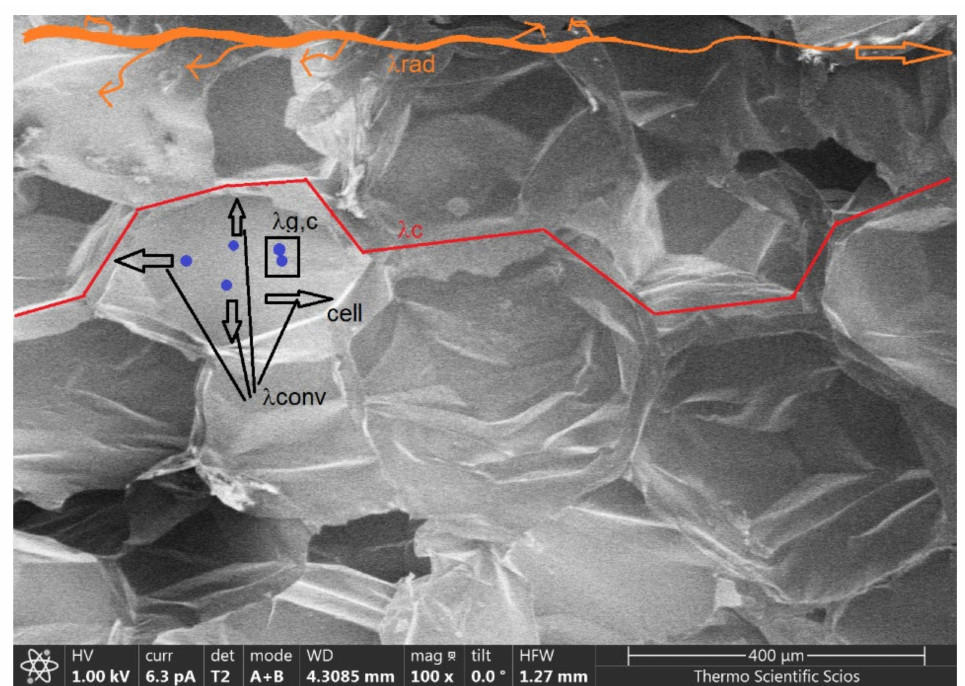
Figure 1. The heat transfer inside the graphite